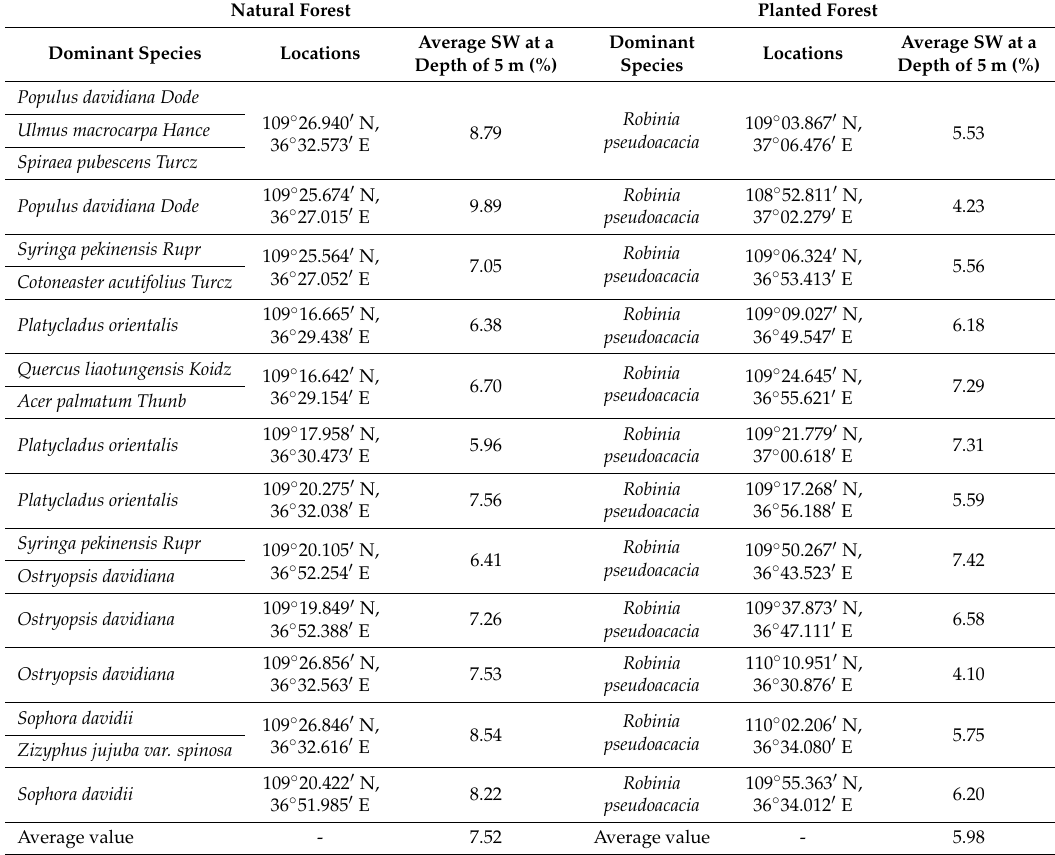
Table 2. The average soil water content (SW) under natural and mismatched planted forest in